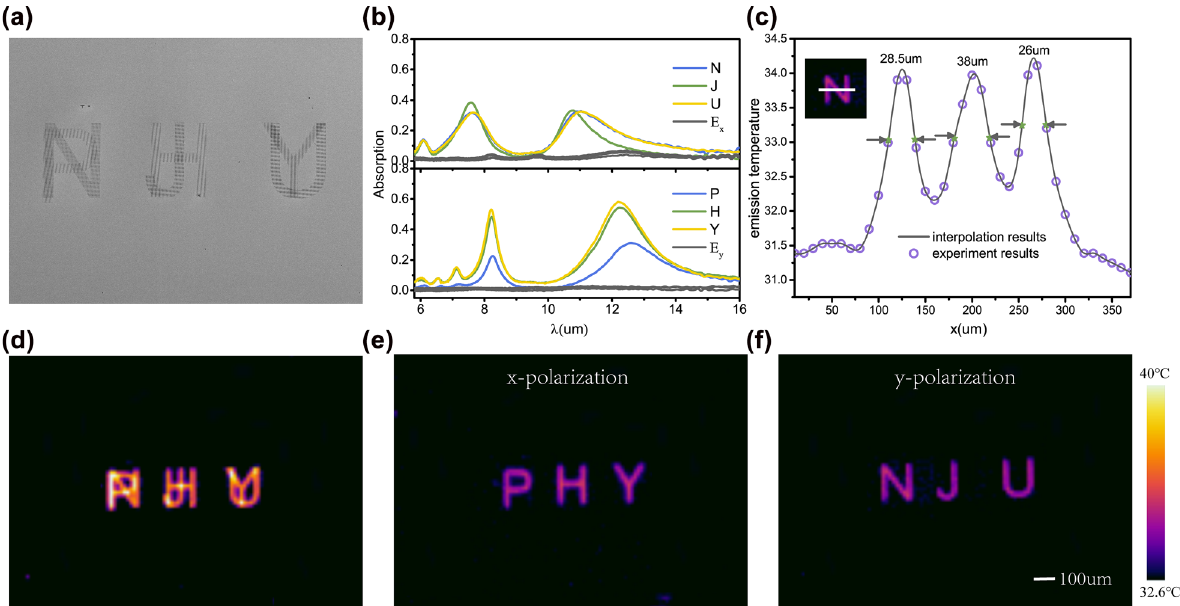
Figure 4: Multiplexing thermal emission based on complex meta-cavity patterns. (a) SEM top view of fabricated meta-cavity patterns. (b) Measured absorption spectra of the NJU (PHY) patterns under y-polarized and x-polarized incidence. (c) The emission temperature distribution along the center line of letter N. Thermal images of two fabricated patterns taken at 100 ◦ C without polarizer (d), with x polarizer (e) and with y polarizer